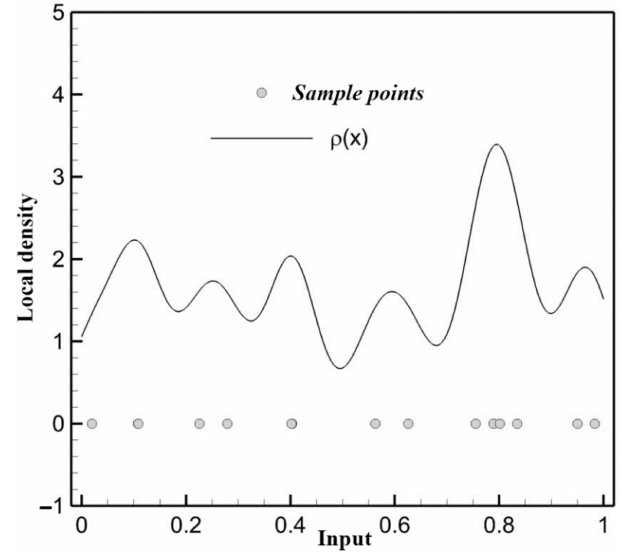
Figure 5. Illustrative example of density in one